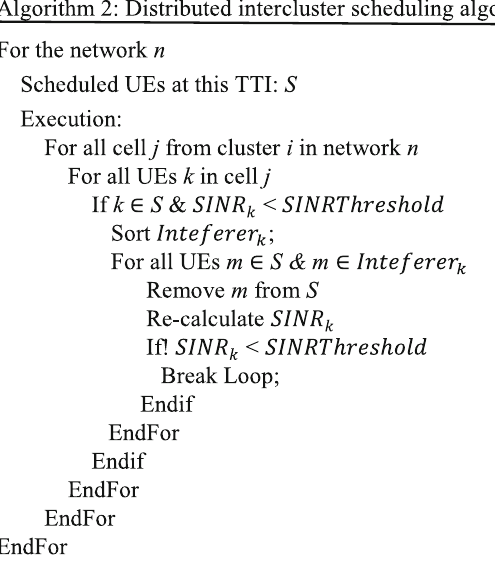
Algorithm 2 tries to turn off all UEs that cause